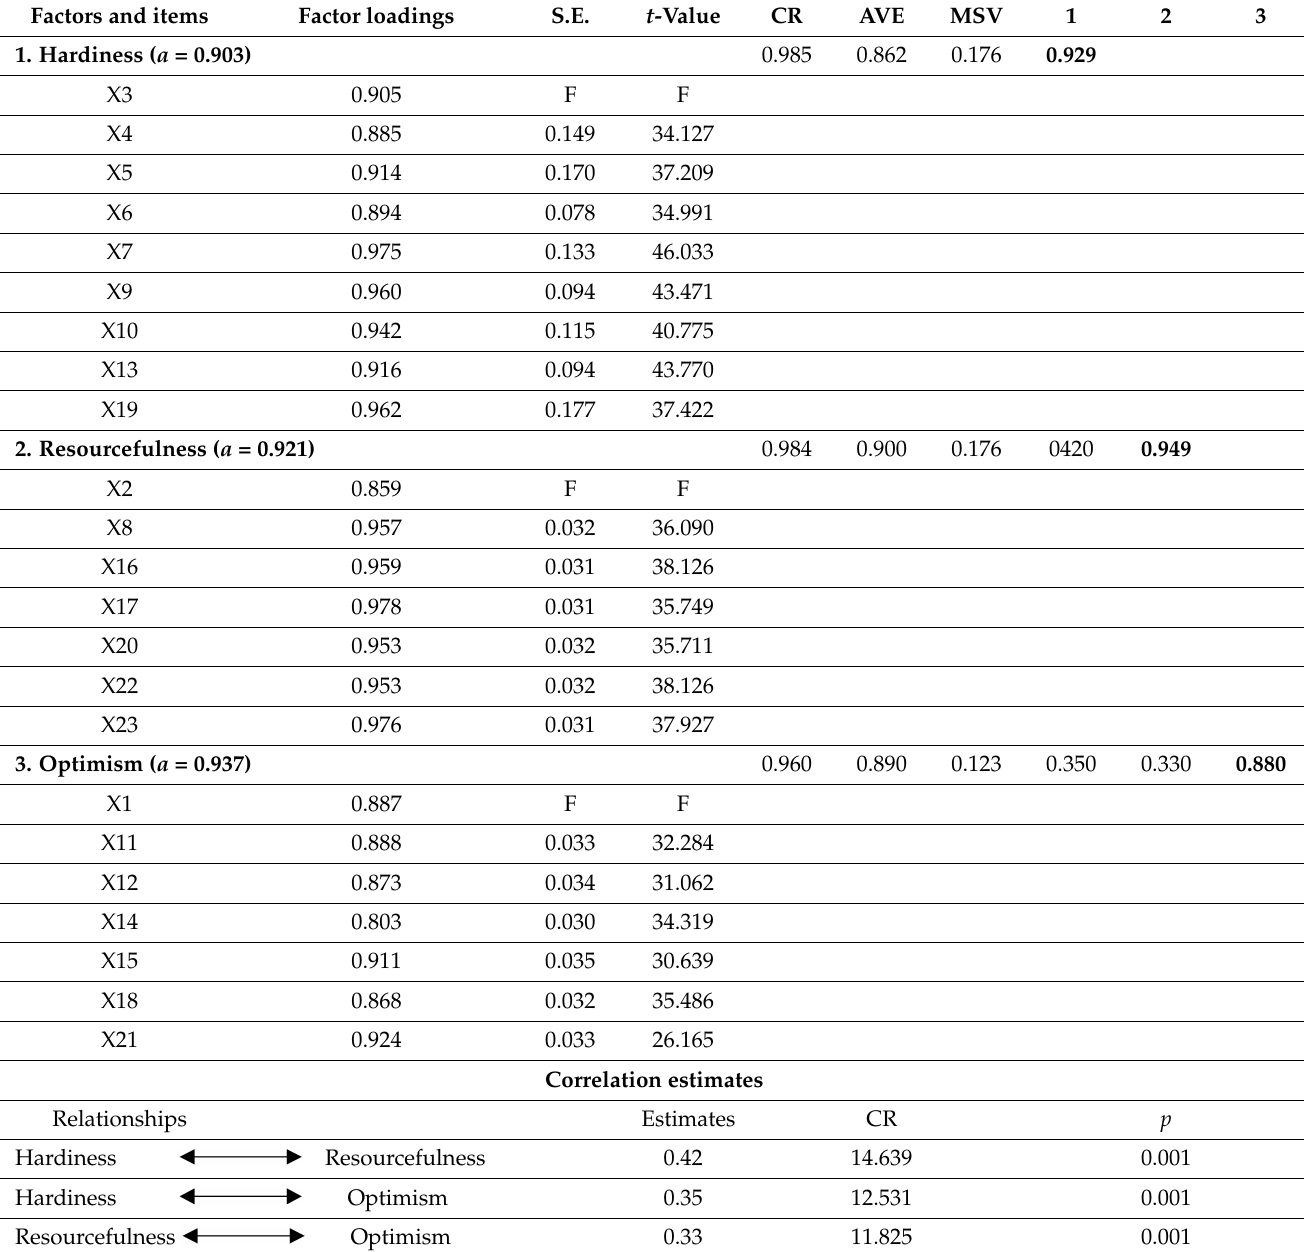
Table 7. Convergent and discriminant validity of the reflective three-factor